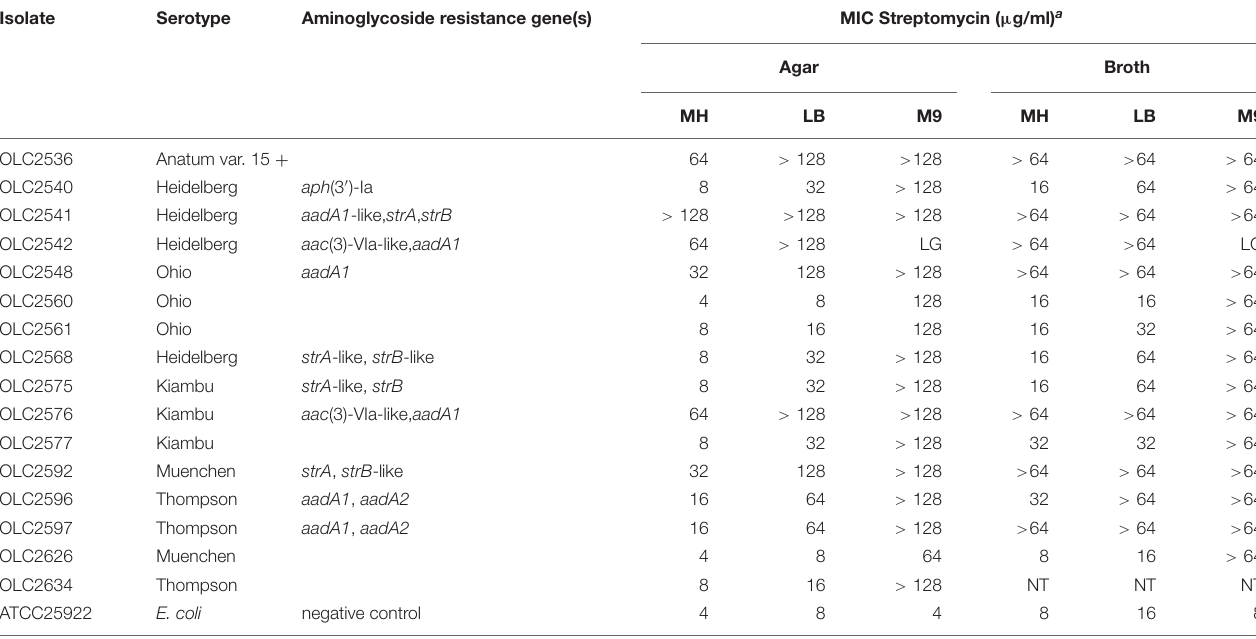
TABLE 8 | STR minimum inhibitory concentration of Salmonella isolates in MH, LB, and M9 agar and broth. Isolate Serotype Aminoglycoside resistance gene(s) MIC Streptomycin ( µ g/ml) a